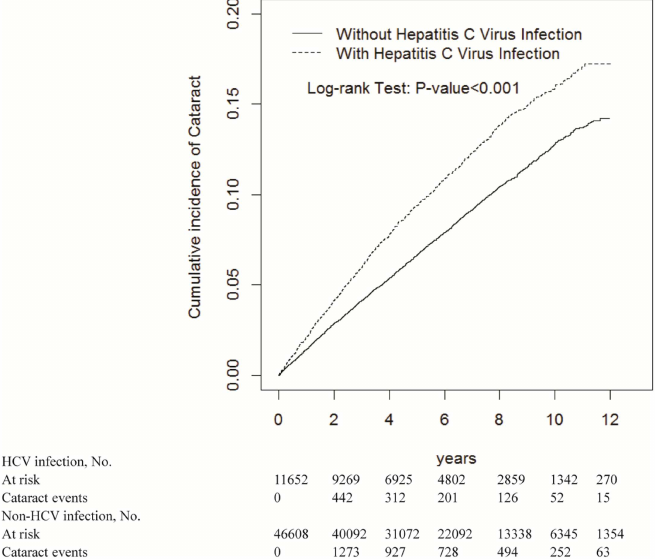
Fig 1. Cummulative incidence comparison of cataractfor patients with (dashed line) or without (solid line) HCV infection.